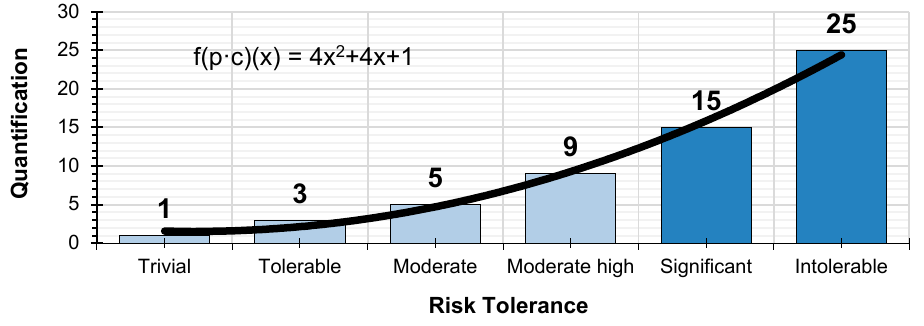
Figure 4. Quantification of risk tolerance.